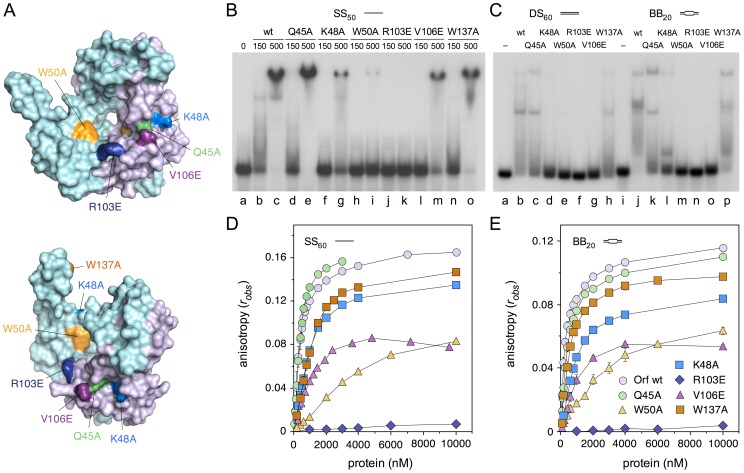
DNA binding by MBP-Orf mutant proteins.(A) Crystal structure of Orf protein (1PC6) highlighting the location of site-directed mutations. Chain A is colored cyan and Chain B, lilac. The projecting C-terminal helix is absent from the latter. (B) MBP-Orf mutant binding to ssDNA. Gel mobility shift assay contained 0.3 nM 32P-labelled ssDNA (SS50) and protein at 150 and 500 nM as indicated. Samples were separated on 4% polyacrylamide gel electrophoresis and visualized by autoradiography. (C) MBP-Orf mutant binding to double-stranded and bubble DNA. The gel shift assay contained 0.15 nM 32P-labelled dsDNA (DS60; lanes a-h) or bubble DNA (BB20; lanes l-p) and 250 nM MBP-Orf protein. Samples were separated by 4% polyacrylamide gel electrophoresis and visualized by autoradiography. (D and E) MBP-Orf mutant binding to 10 nM fluorescein-labeled ssDNA (D) and BB20 DNA (E) as determined by fluorescence anisotropy. Binding isotherms are colored as in (A). Data are the mean and standard deviation of two independent experiments.